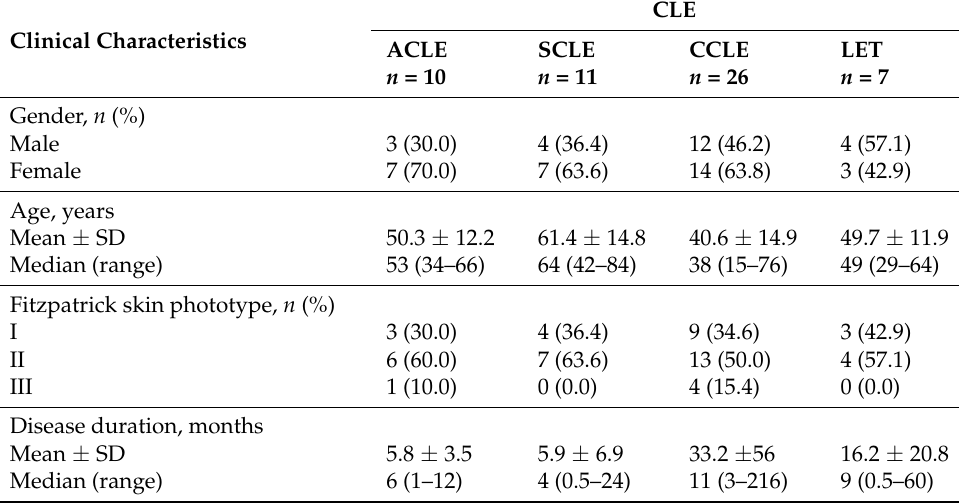
Table 1. Clinical characteristics of study participants (SD—standard deviation; CLE—cutaneous lupus erythematosus; ACLE—acute cutaneous lupus erythematosus, SCLE—subacute cutaneous lupus erythematosus; LET—lupus erythematosus tumidus).